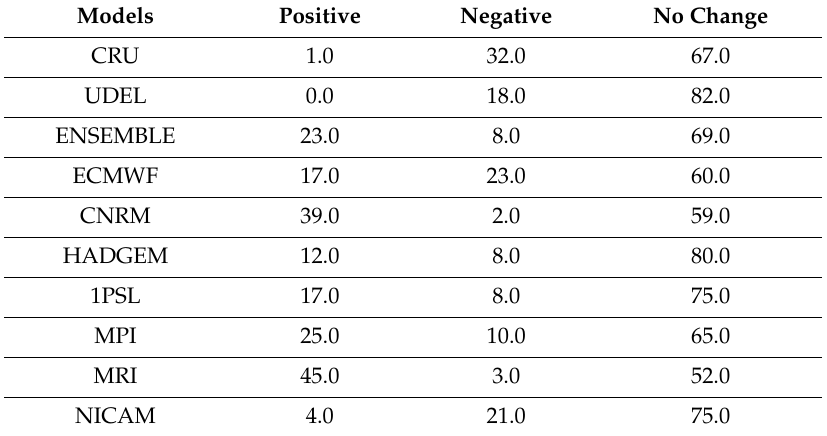
Table 2. The di ff erence in precipitation between 1955–1984 and 1985–2014 presented as a percentage.